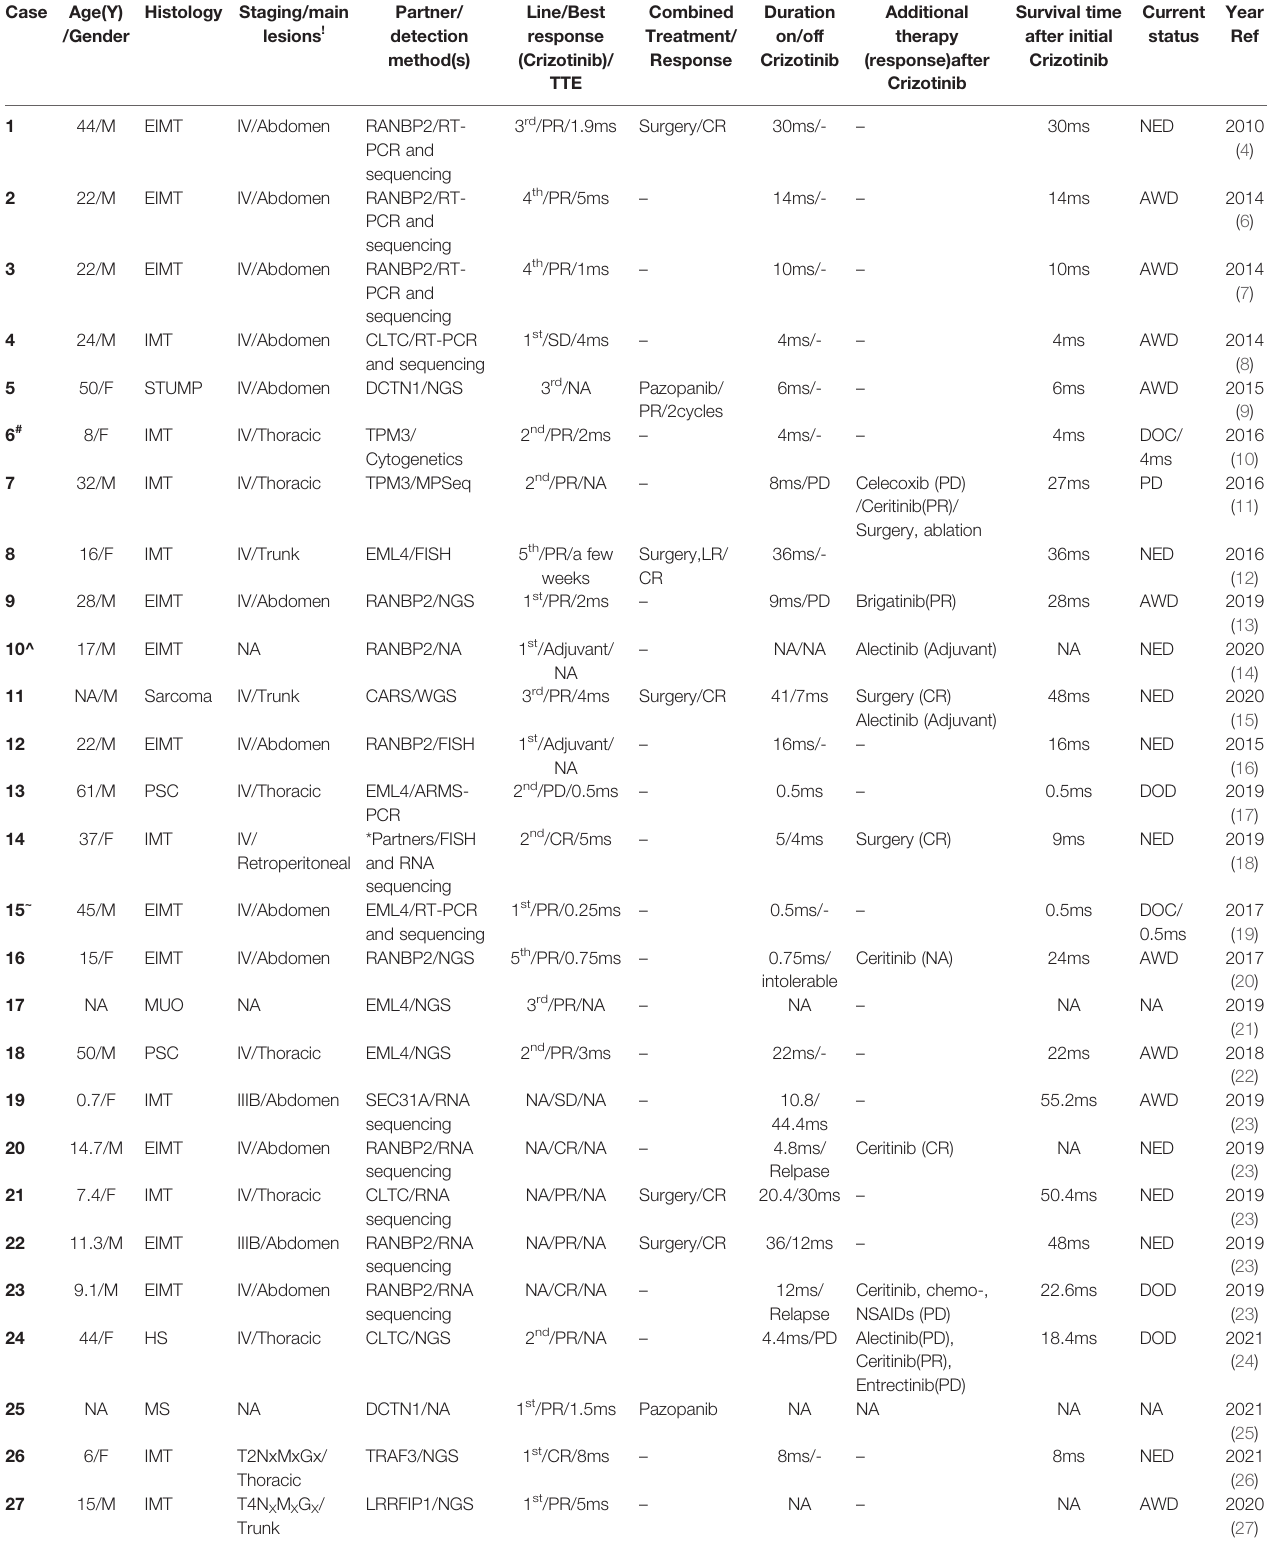
TABLE 1 | Crizotinib treatment in ALK-fusion sarcoma and sarcomatous malignancies. Case Age(Y) Histology Staging/main /Gender lesions